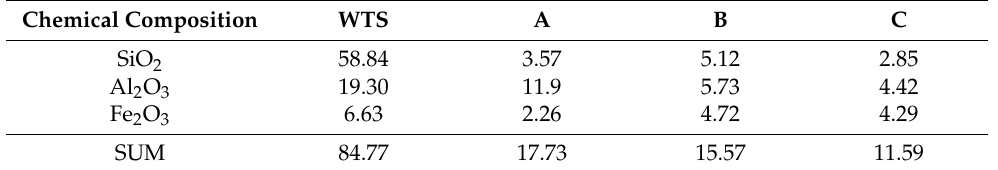
Table 3. Chemical composition of sludge samples (% by weight).